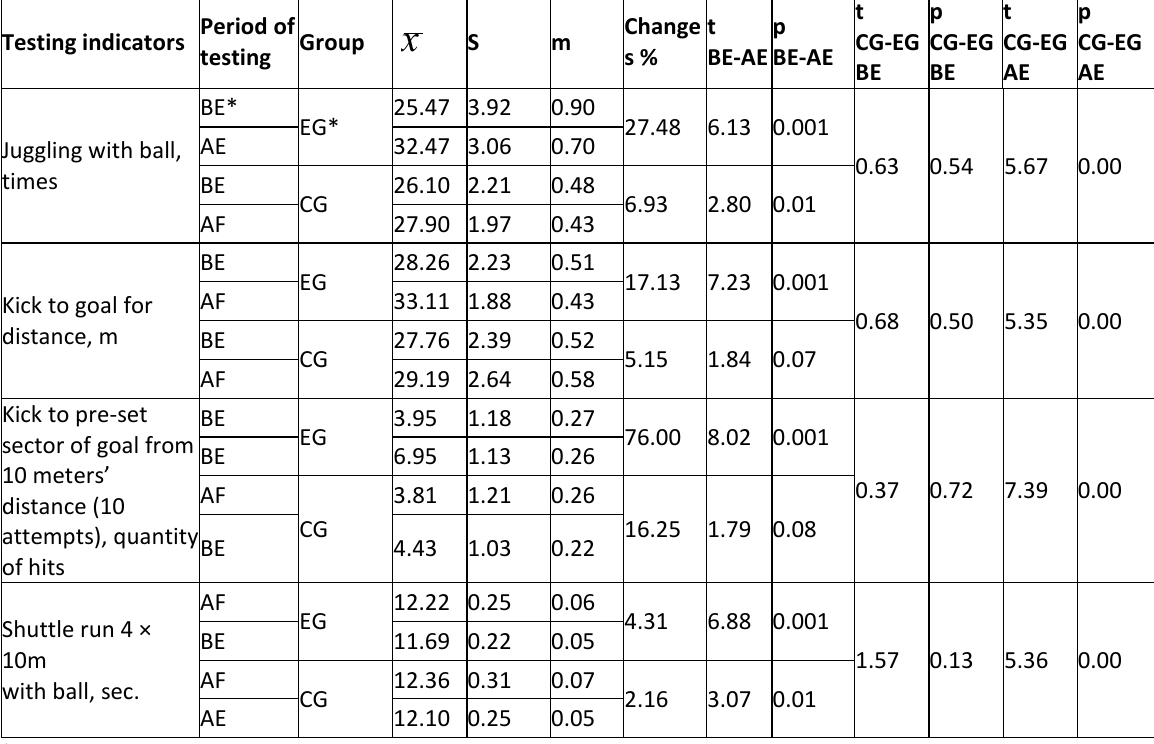
Table 1. Indicators of technical fitness of control group students (n=21) and experimental group students (n=19) before and after experiment Period of Testing indicators